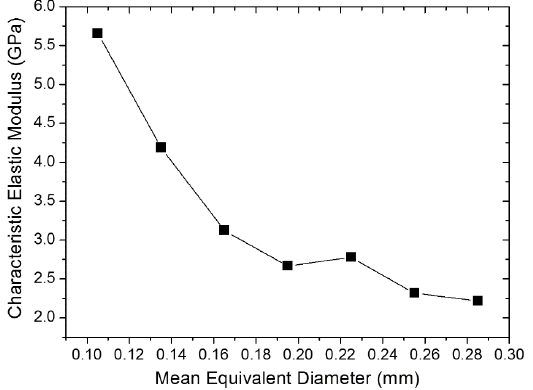
Figure 5. Variation of the Weibull characteristic elastic modulus with the mean equivalent diameter for each interval in Figure 3. Source: authors.